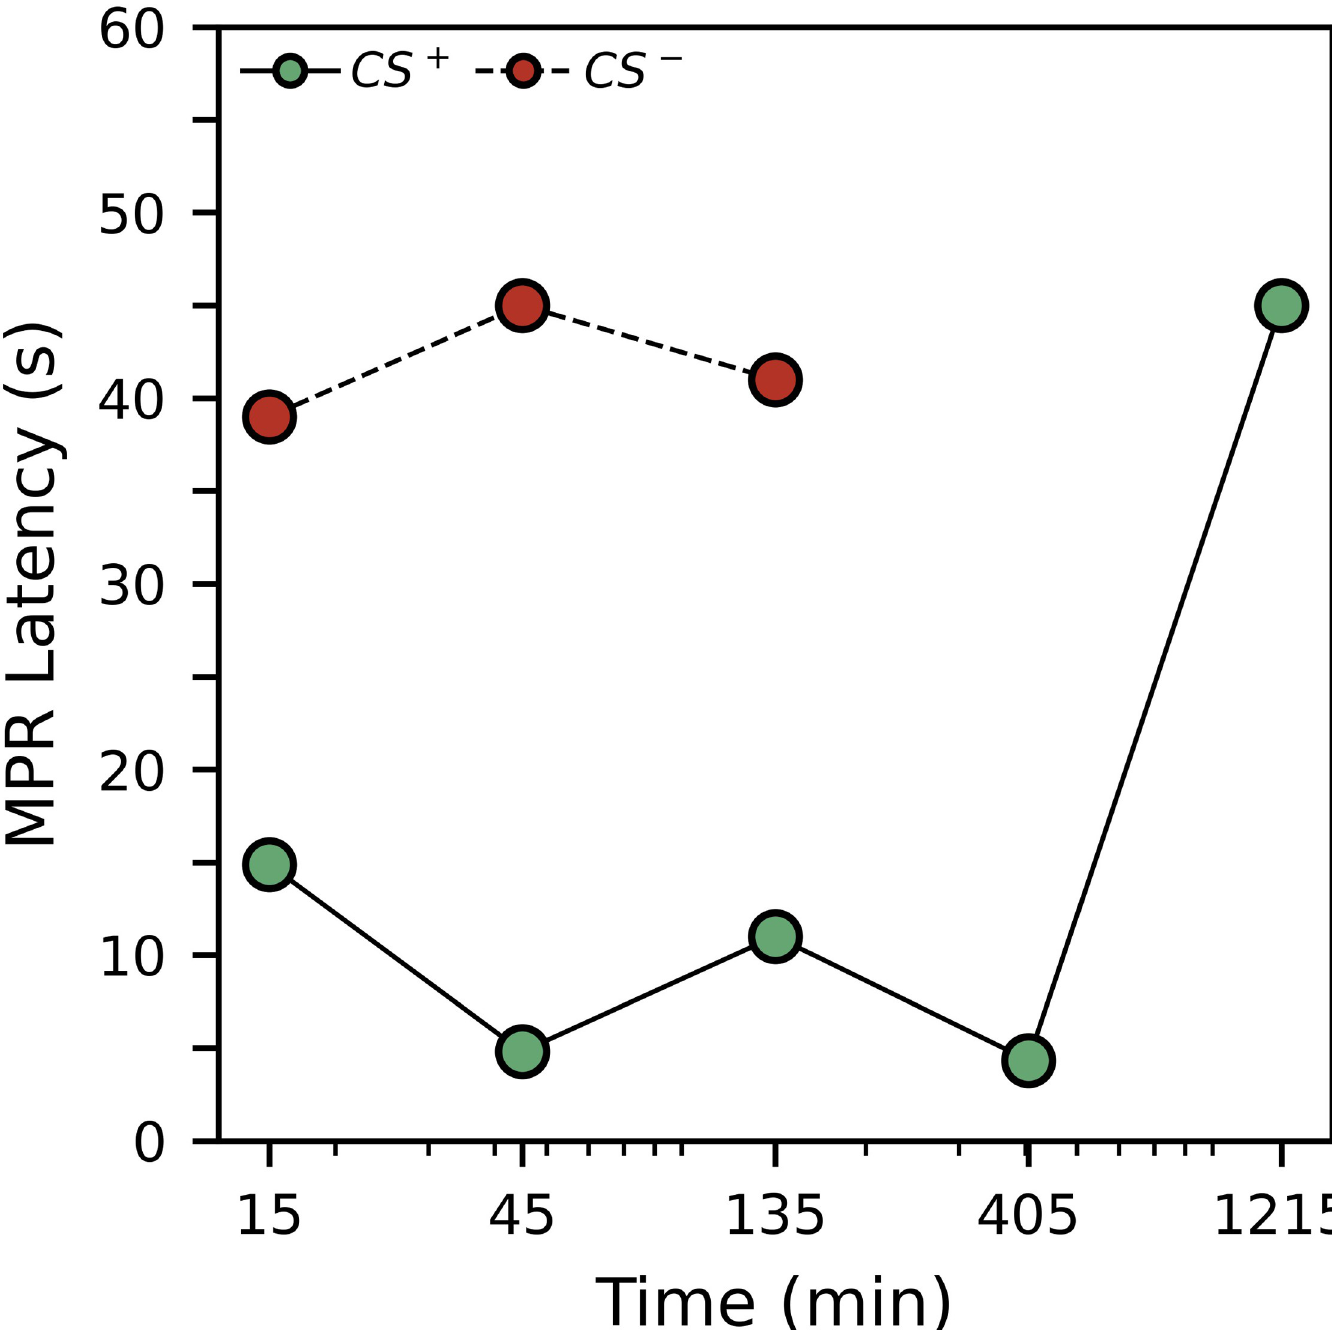
Fig 6. Experiment 2 average MPR latency to respond to the CS + and CS - during the preference test. Averaged values exclude non-responders. For the CS + , the sample sizes were 7, 9, 8, 6 and 1 for 15-, 24-, 135-, 405- and 1,215-minute delay groups, respectively. For the CS - , the sample sizes were 2, 1, 2,